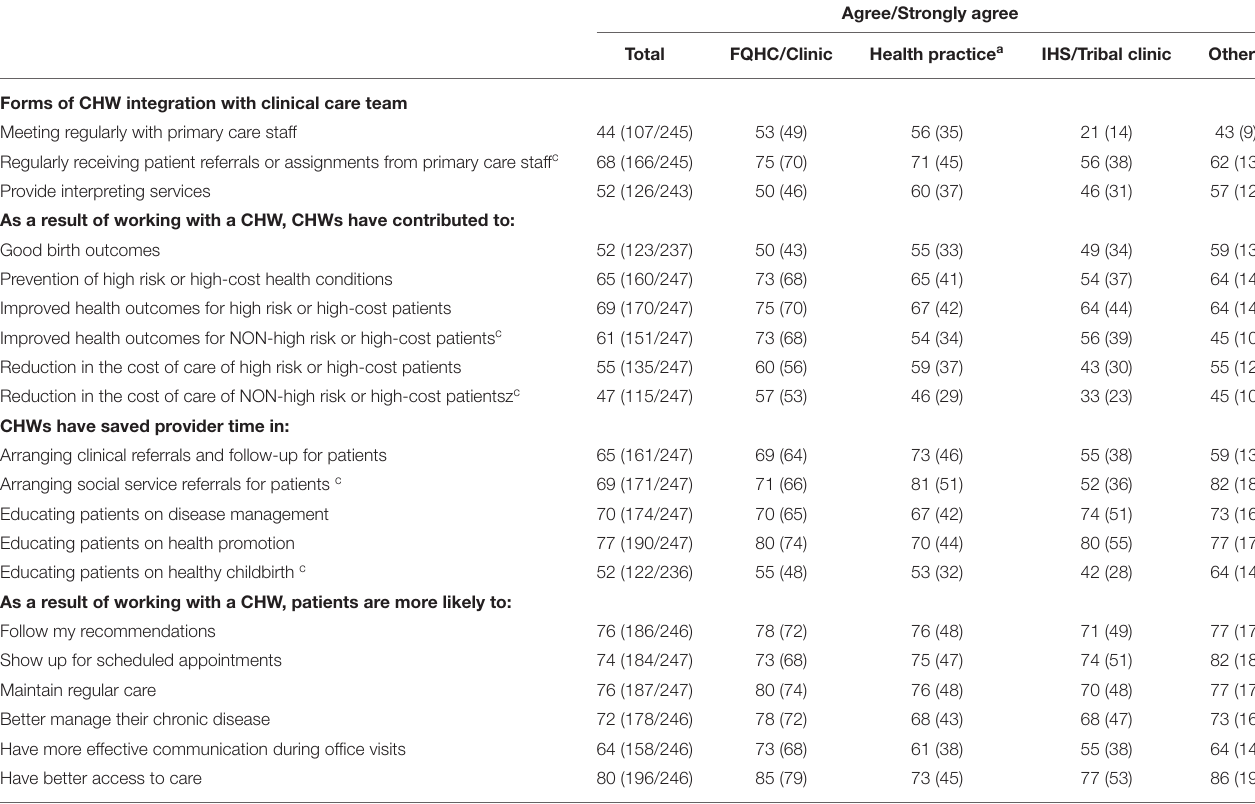
TABLE 2 | Forms of CHW integration and licensed health care provider attitudes and beliefs about the impact of CHW integration patient health outcomes, provider time and cost of care.